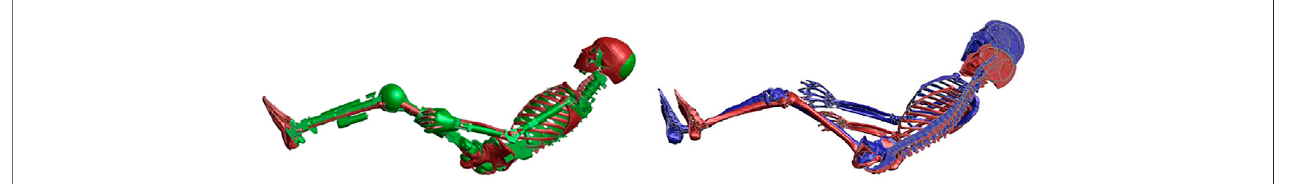
FIGURE2| Left:overlayofSAFERHBMv9mid-sizedmale(red)andTHOR-50M(green).Right:overlayofSAFERHBMv9mid-sizedmale(red)andmorphedlarge male (blue).